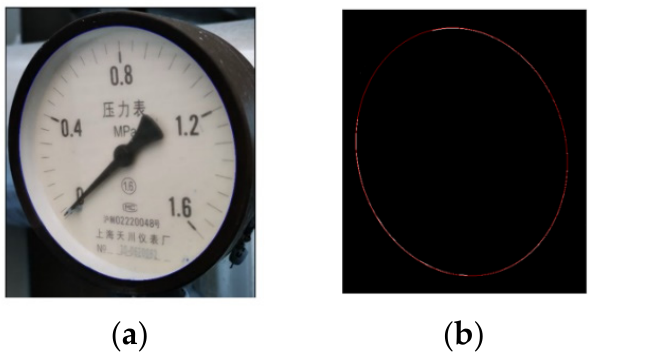
Figure 5. Deep learning and ellipse detection results: ( a ) deep learning detection results; ( b ) ellipse detection results.